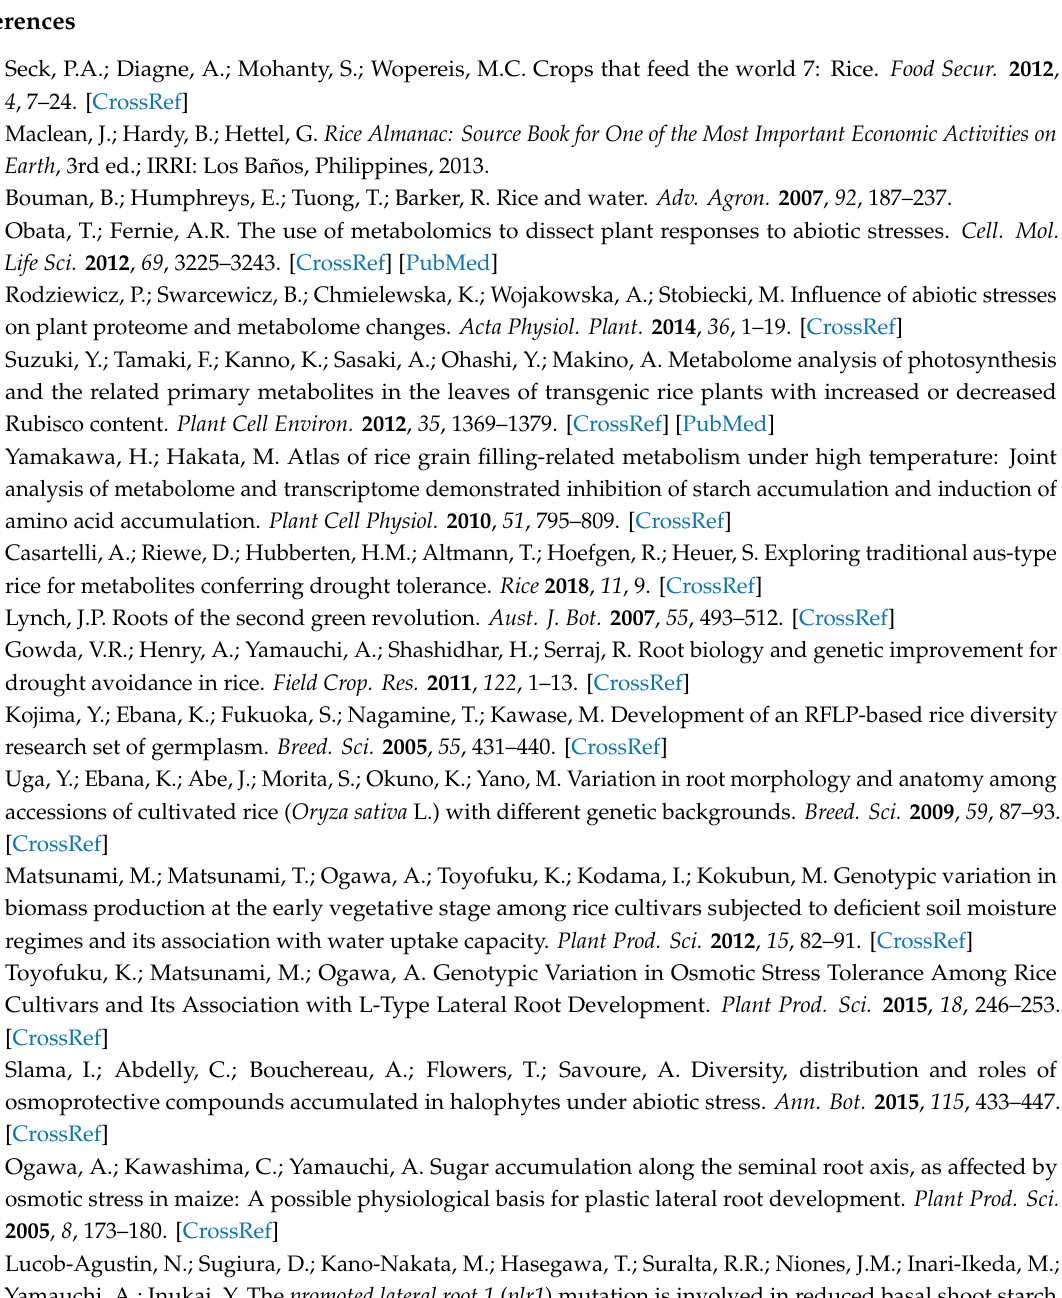
Table S1: loading of primary component (PC)1 and PC2 among 276 metabolites in the roots of two rice